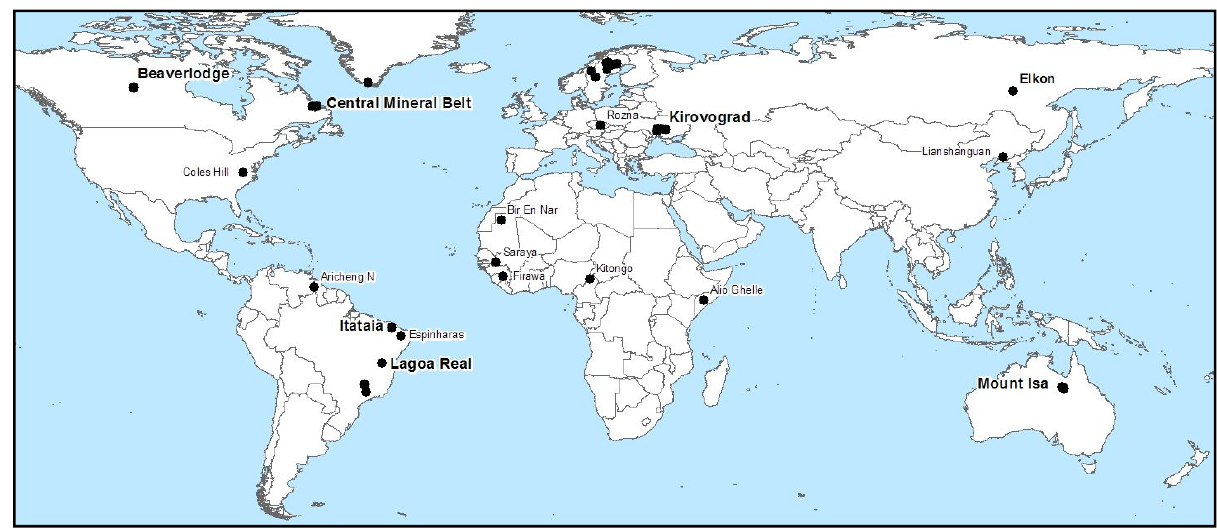
Figure 1. Location of albitite-type (and related) uranium